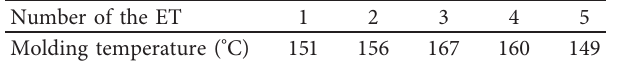
Figure 13: Gradations of the asphalt mixture by the ETs. Table 15: Asphalt-stone ratio of the asphalt mixture by the ETs. Number of the ET 1 Asphalt-stone ratio (%) Table 16: Molding temperatures of the asphalt mixture. Number of the ET